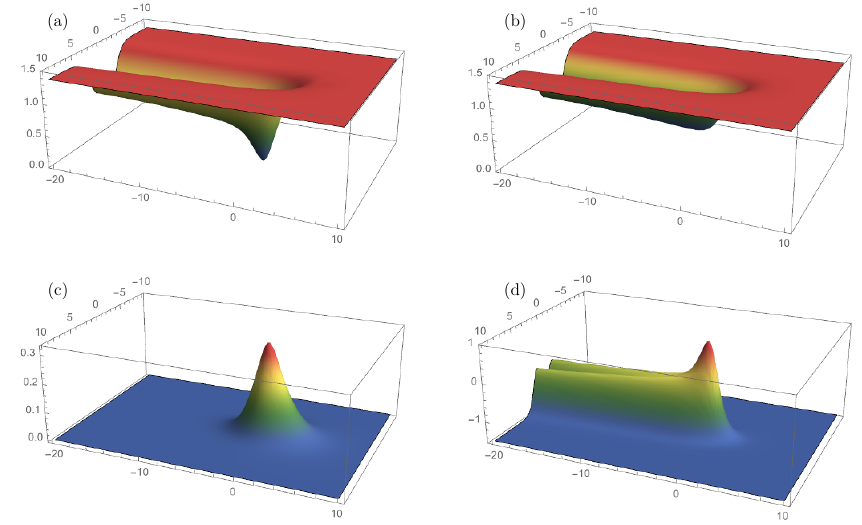
Figure 15 . A snap shot of the (1 ; 0)-string with a domain wall for (cid:24) = 5 (cid:25)= 4 on the plane orthogonal to the string. The panels (a) and (b) show the absolute square of the upper-left (winding) and the lower-right (unwinding) components, respectively. (c) shows the Z -(cid:13)ux and (d) shows the full energy